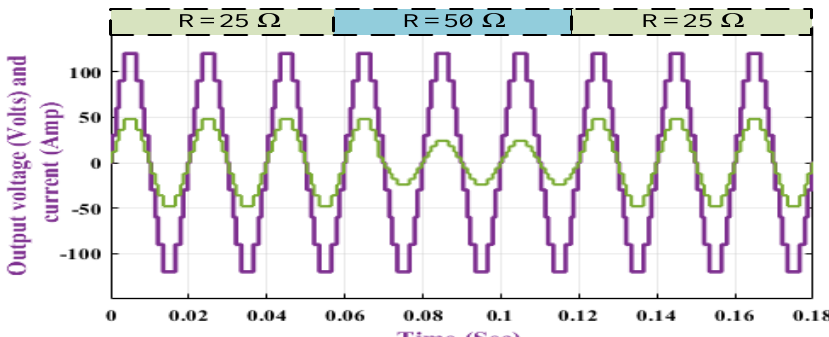
Figure 15. Dynamical R load in seven-level changing from 25 Ω–50Ω– 25 Ω. The current waveform is multiplied by 10.